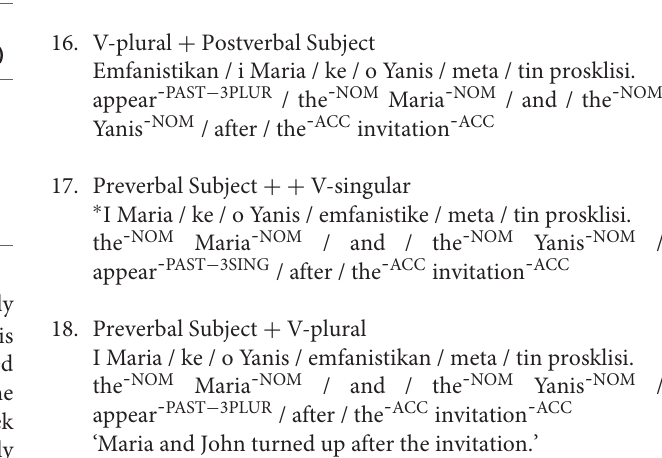
TABLE 1 | Descriptive statistics for the factorable bilingual profile characteristics (N: